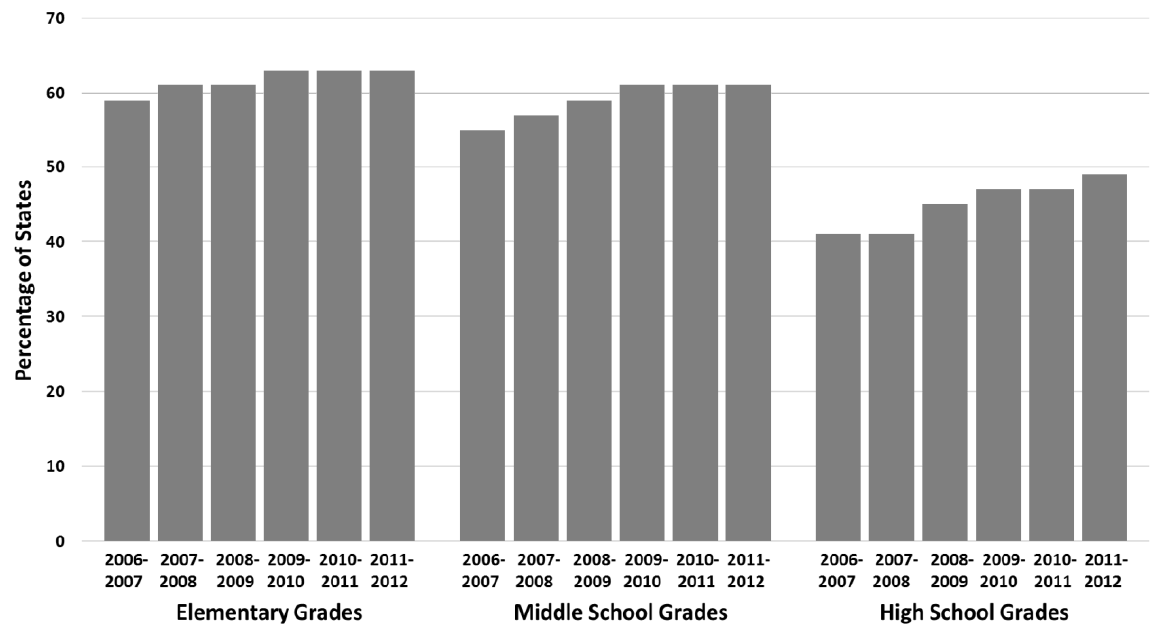
Figure C-7. Percentage of States with a Clear Physical Education Policy, by Level of School, School Years 2006-2007 to 2011-2012